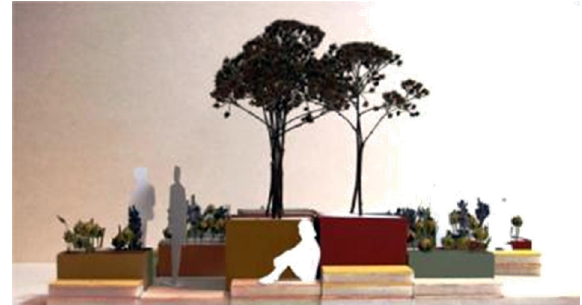
Picture 1. A scale model of the community garden at Liberty Square.